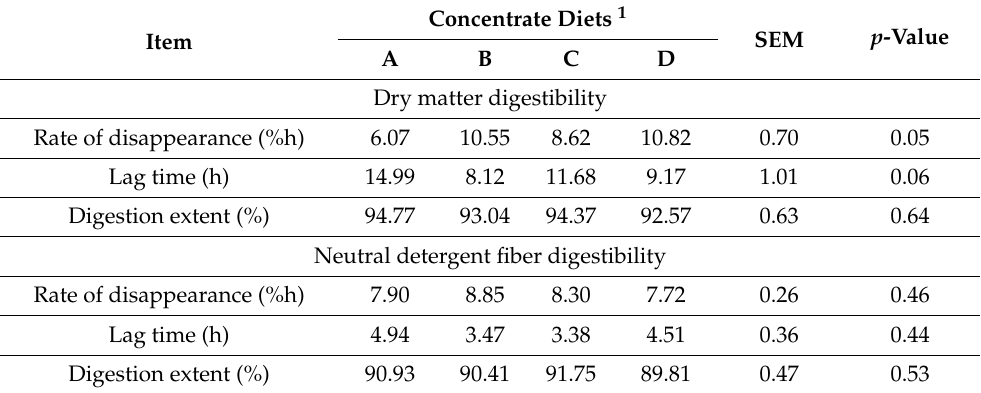
Table 6. Effect of different levels of yeast-fermented citrus pulp on in situ nutrient digestibility in cannulated buffalo